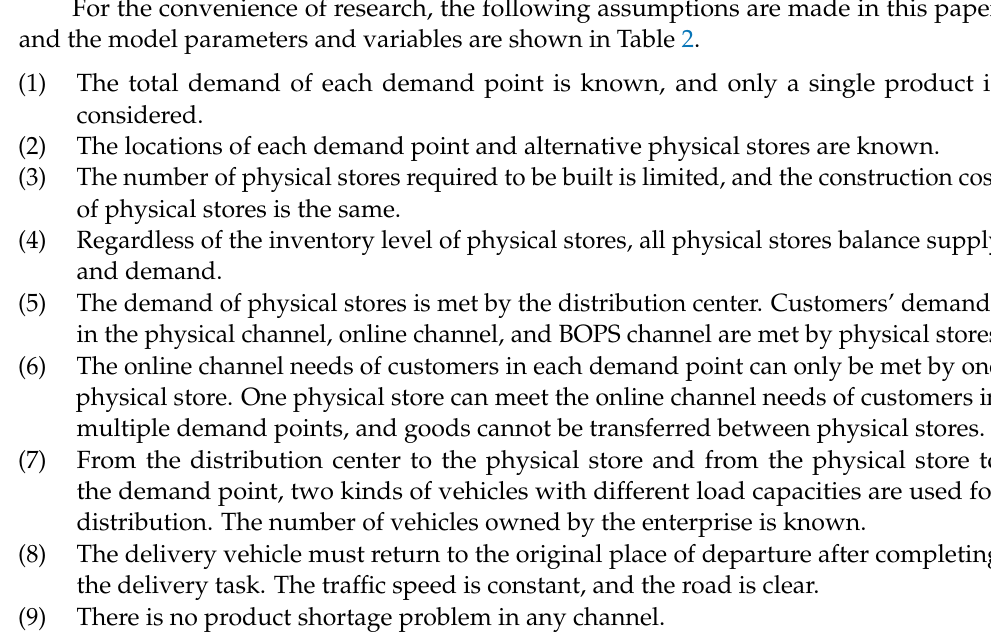
Table 2. Model parameters and decision variables. Parameters